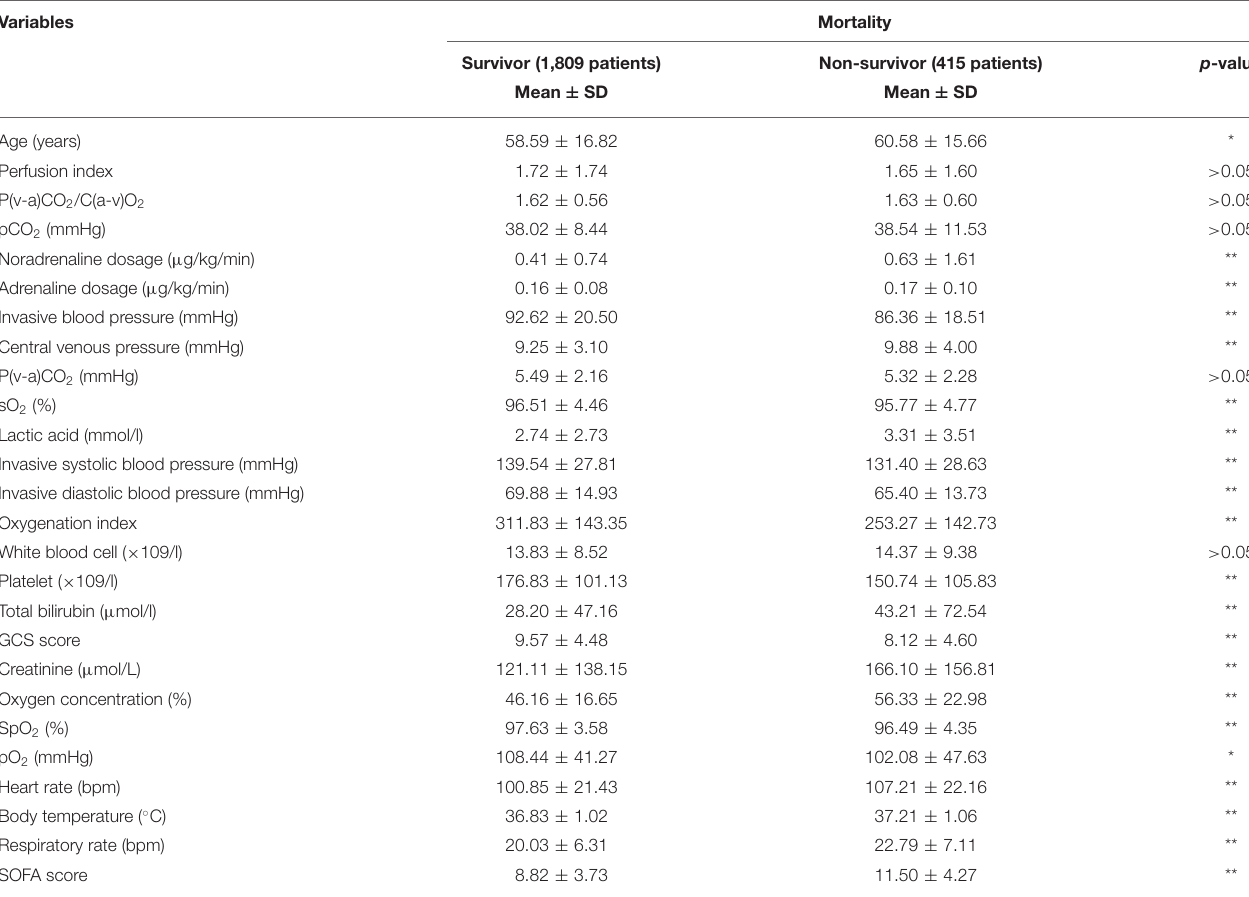
Table 1A | Subgroups of patients’ clinical data for the mortality prediction.